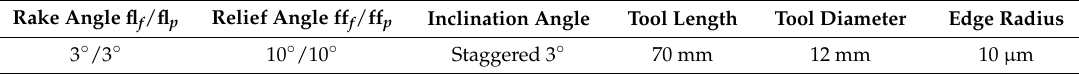
Table 1. Structural parameters of the PCD end